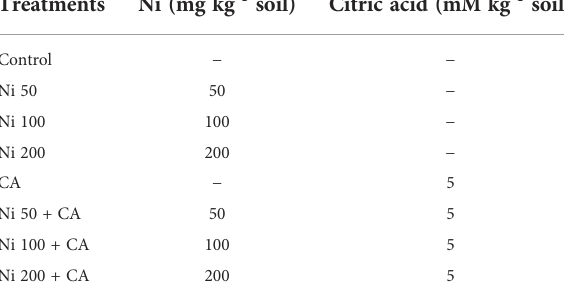
TABLE 1 Treatments performed in this pot